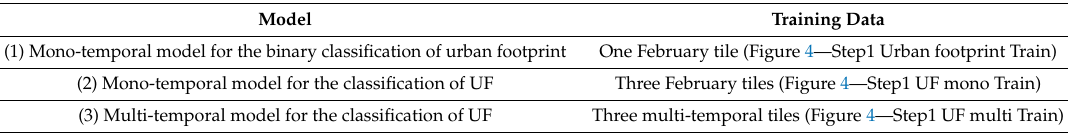
Table 3. The data used for training each